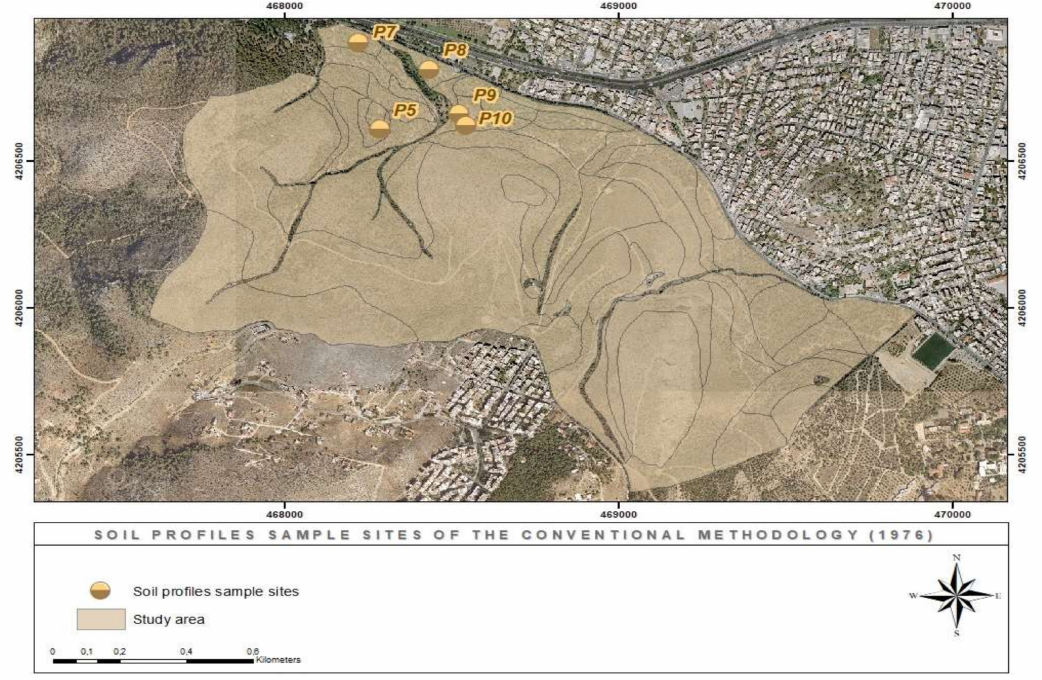
Figure 2. Soil profiles sample sites of the conventional soil mapping